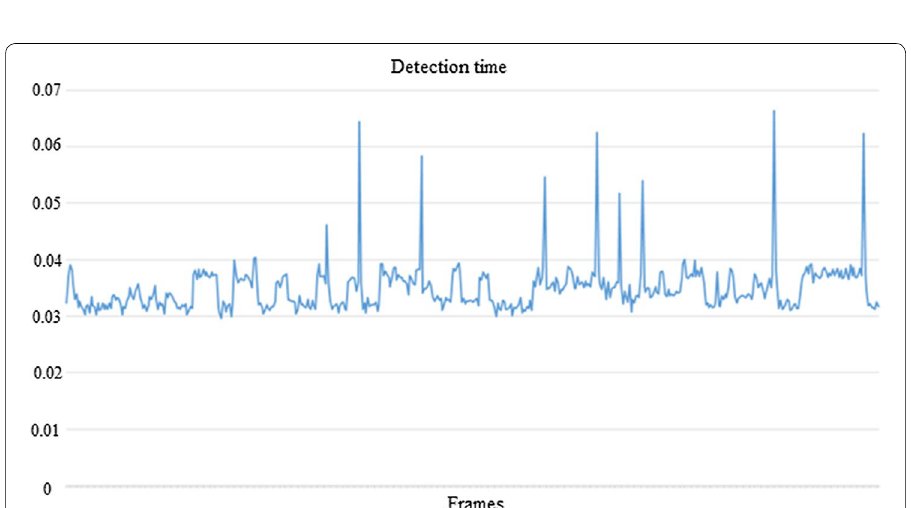
Fig. 18 The time spent on vehicle detection for one